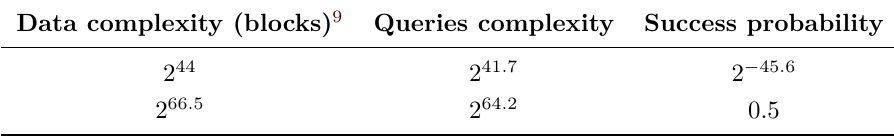
Table 4: Full attack